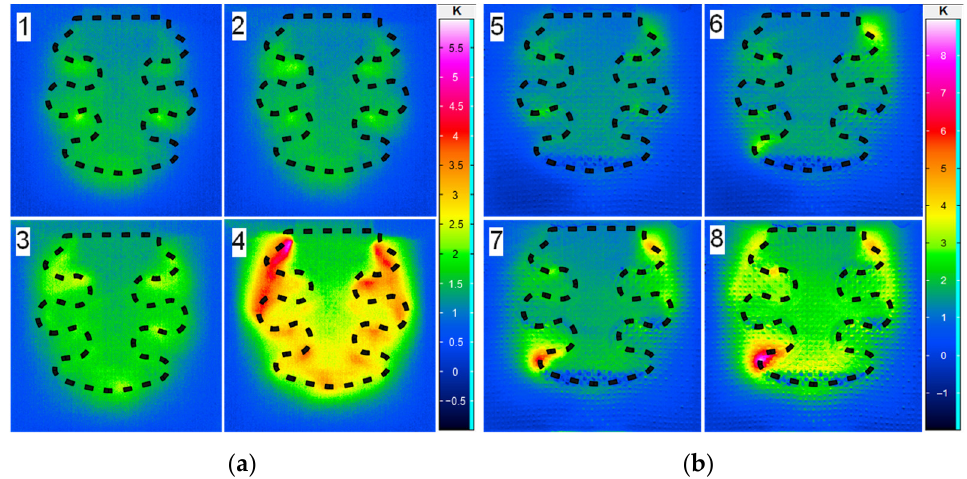
Figure 11. Δ T-thermograms of the hybrid specimens in dynamical testing @ 23 °C ( 1 – 4 ) and 60 °C ( 5 – 8 ); ( a ) @ 10 4 , 3 × 10 4 , 6 × 10 4 , 10 5 cycles; ( b ) @ 10 4 , 2 × 10 4 , 3 × 10 4 , 4 × 10 4 cycles.